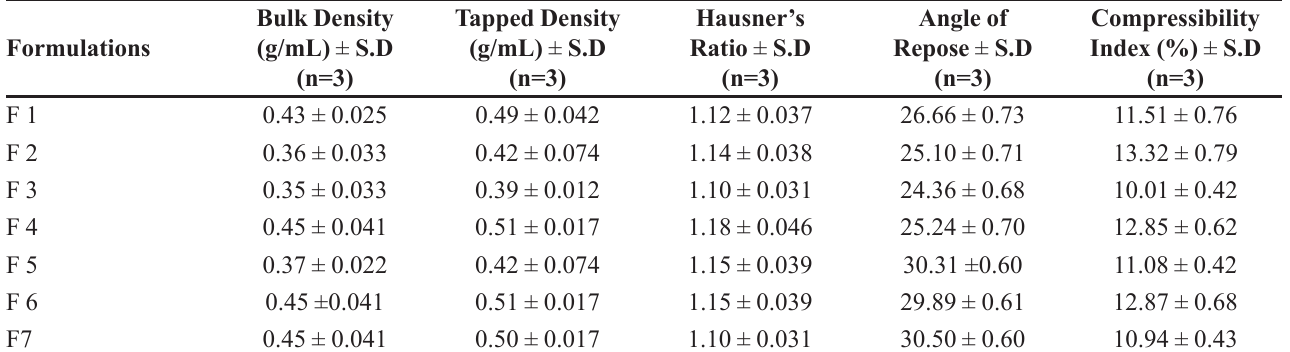
TABLE II - Pre-compression parameters of the formulations